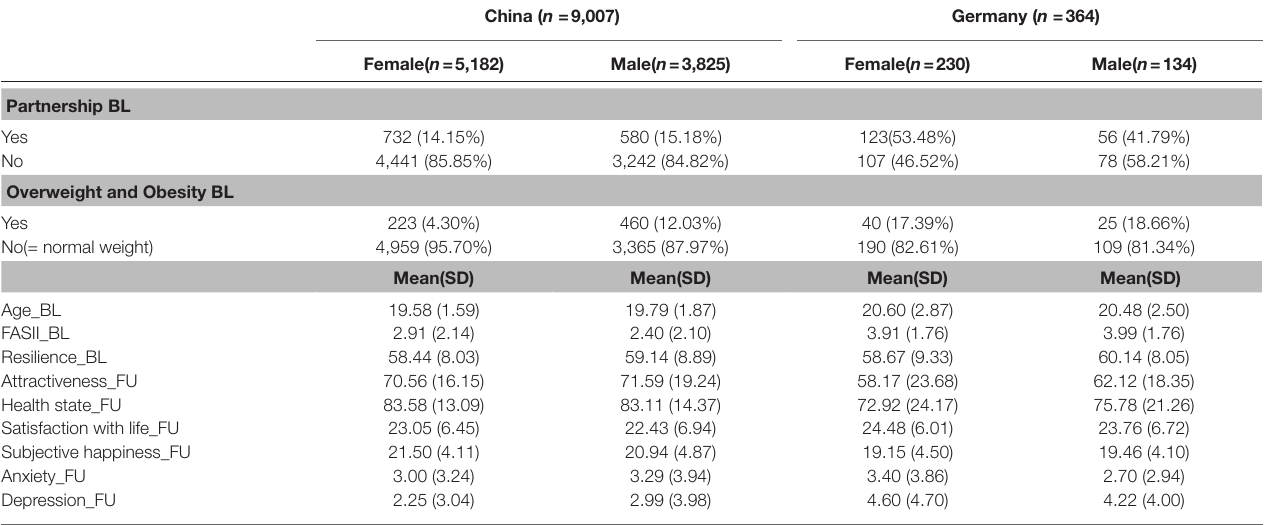
TABLE 1 | Descriptive statistics of sociodemographic variables and